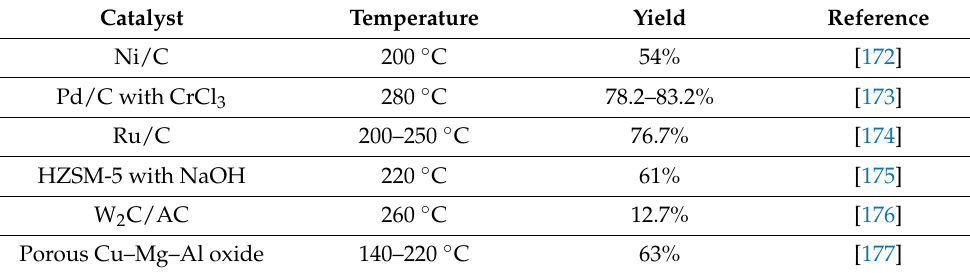
Table 3. Effects of temperature-catalyst changes on yield during the lignin hydrogenation process. Catalyst Temperature Yield Reference Ni/C 200 ◦